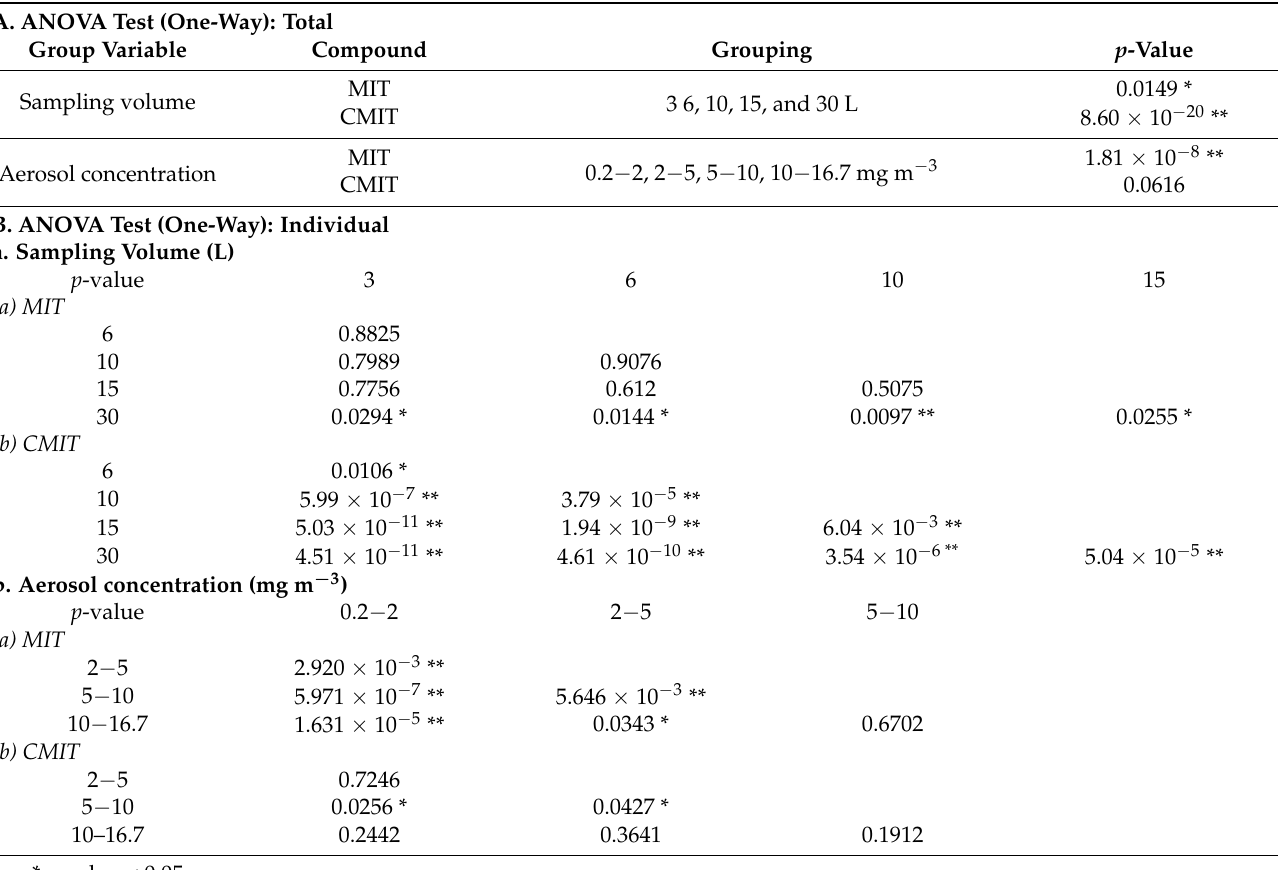
Table 4. Results of the statistical analysis of the relative concentrations of MIT and CMIT on the glass fiber filters with the different sampling volumes and the aerosol